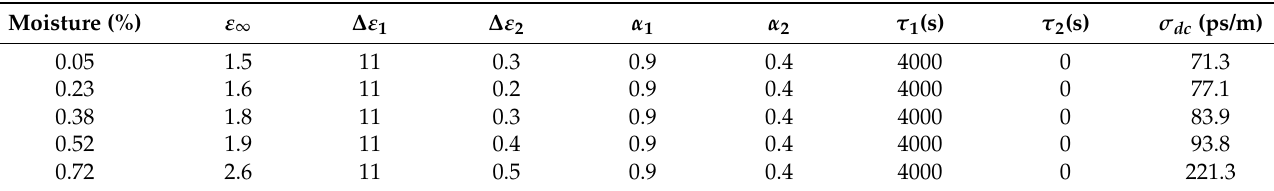
Table 2. Fitting parameters of oil-immersed insulating paper.